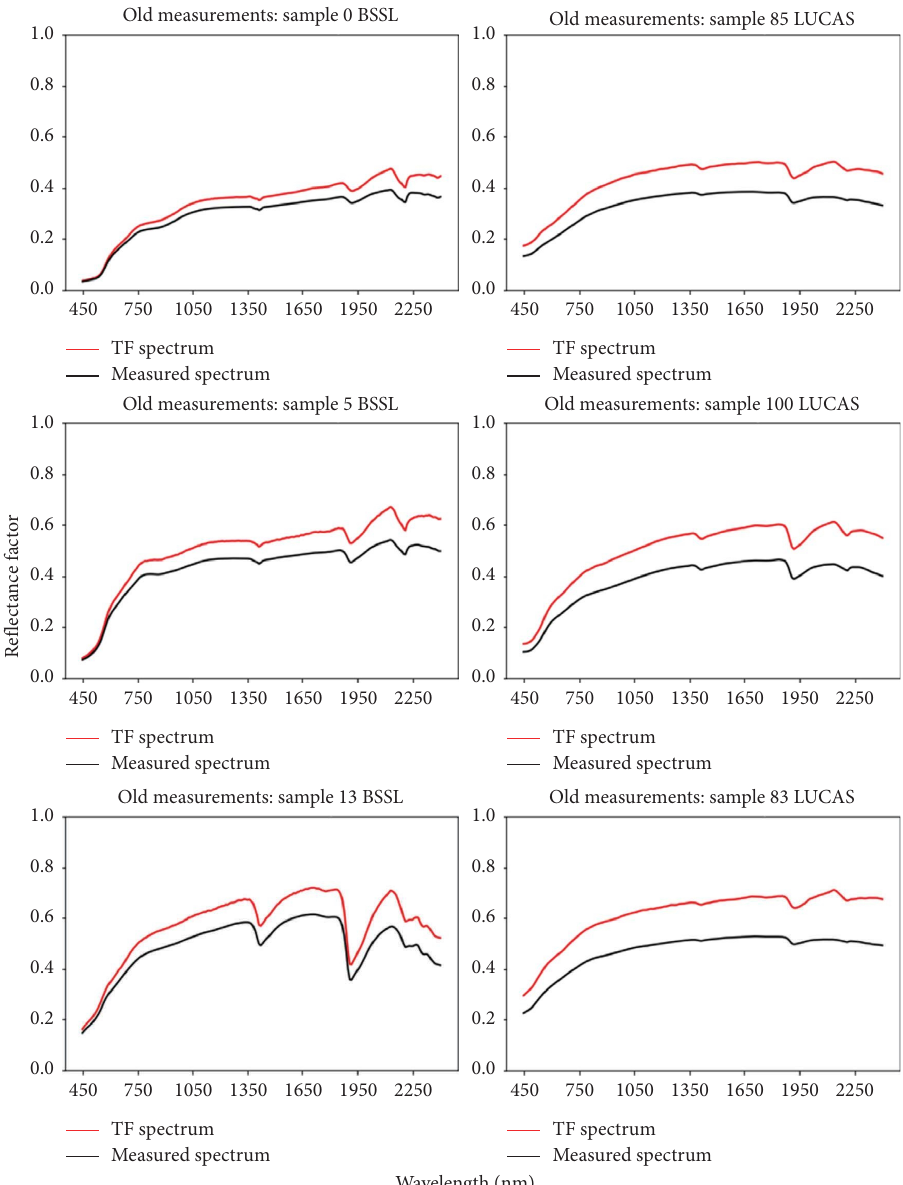
Figure 5: Examples of the TFs1 rectifcations of the old–original measurements from the rectifcation group: red—TF spectra, and black—measured spectra before TF